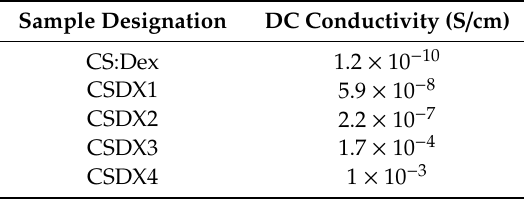
Table 1. Conductivity for pure CS:Dex and blend electrolyte films at room